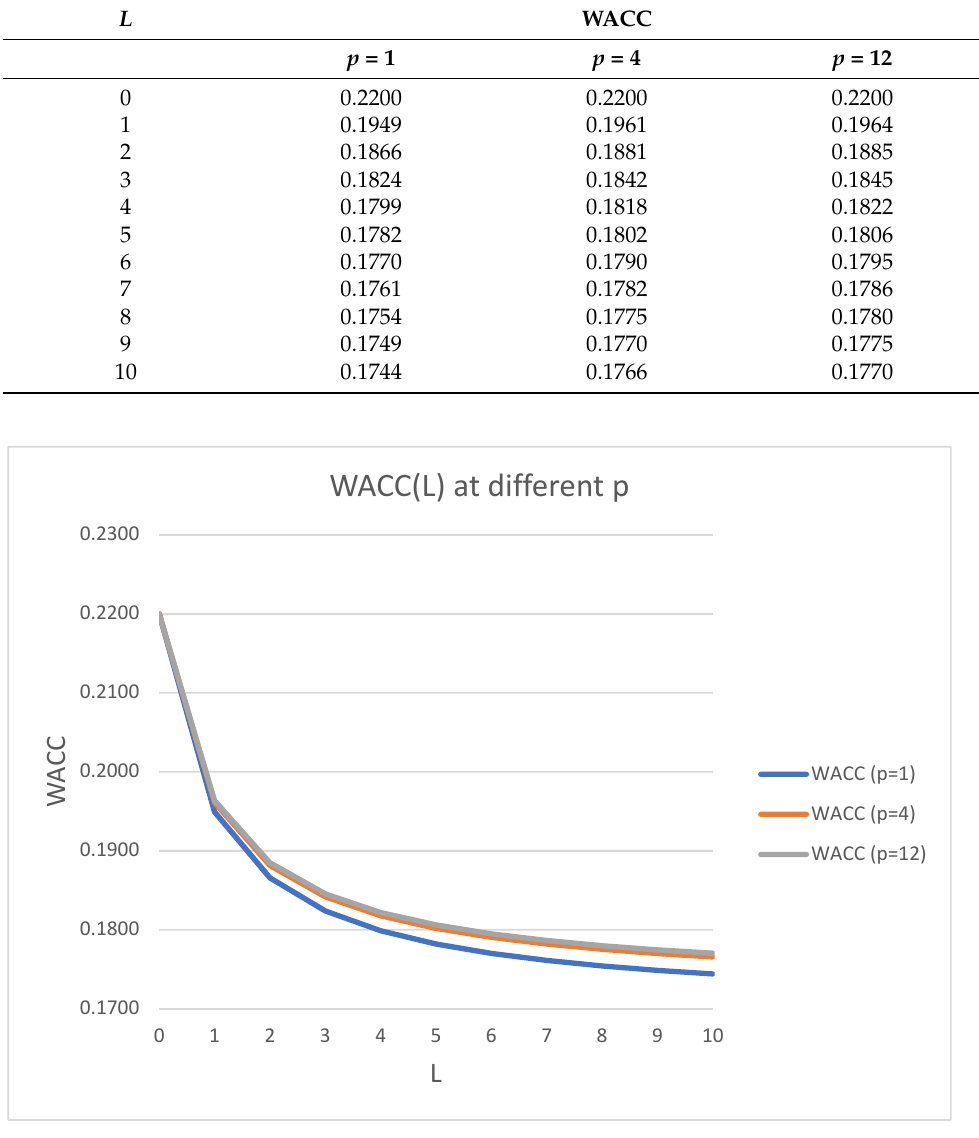
Figure 2. Change of weighted average cost of capital, WACC, with leverage, L , for k d = 0.14, k 0 = 0.22, and p = 1, 4, and 12.